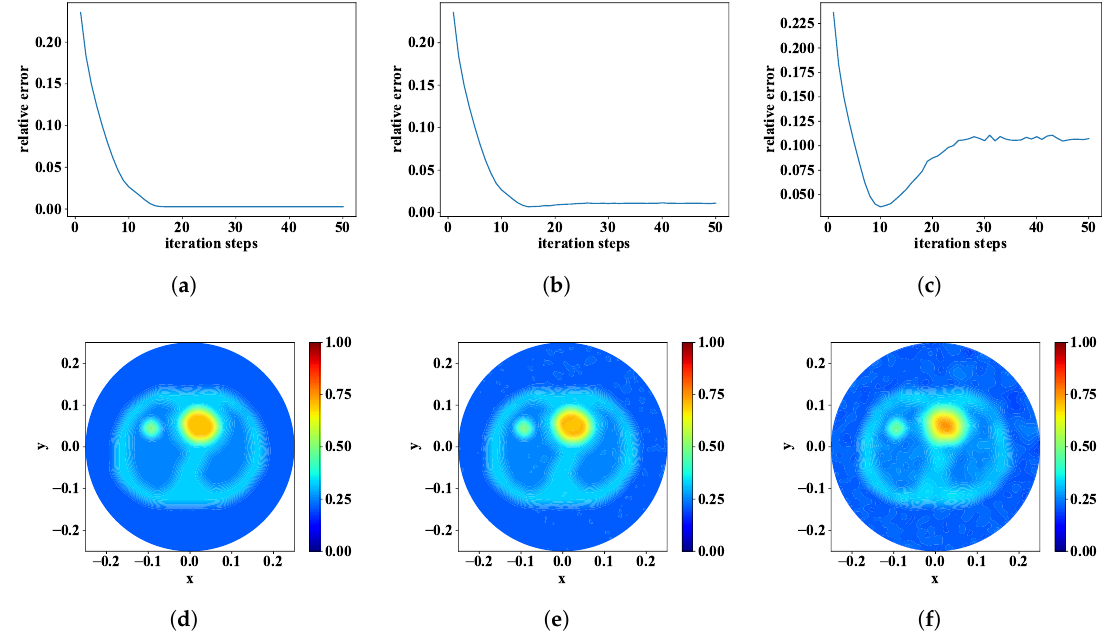
Figure 15. The relative error and reconstructed conductivity map of smooth-heart–lung model with ( a , d ) for SNR = ∞ , ( b , e ) for SNR = 40 dB, ( c , f ) for SNR = 20